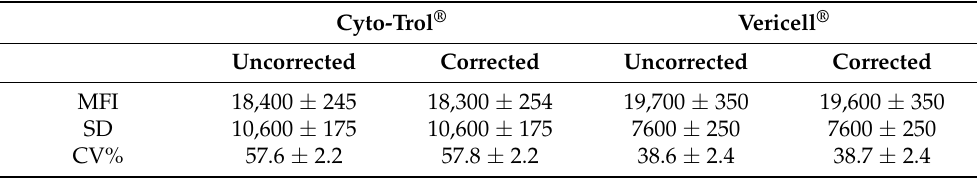
Table 6. MFI and SD of Cyto-Trol ® and Vericell ®